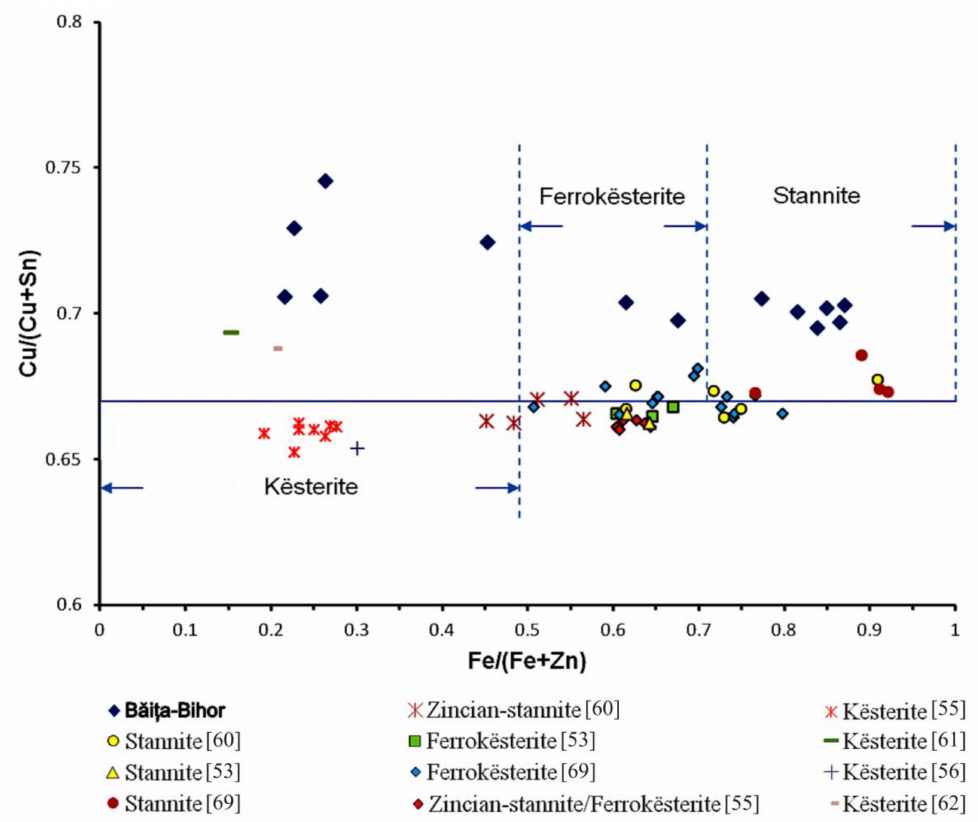
Figure 6. Chemical composition of stannite group minerals shown on a plot of Cu / (Cu + Sn) vs. Fe / (Fe + Zn) after Petruk [60]. Published data from other occurrences are also given. The blue dashed lines separate the approximate stability field of kësterite, ferrokësterite, and stannite based on Fe / (Fe + Zn) ratio according to intervals proposed by Watanabe et al.